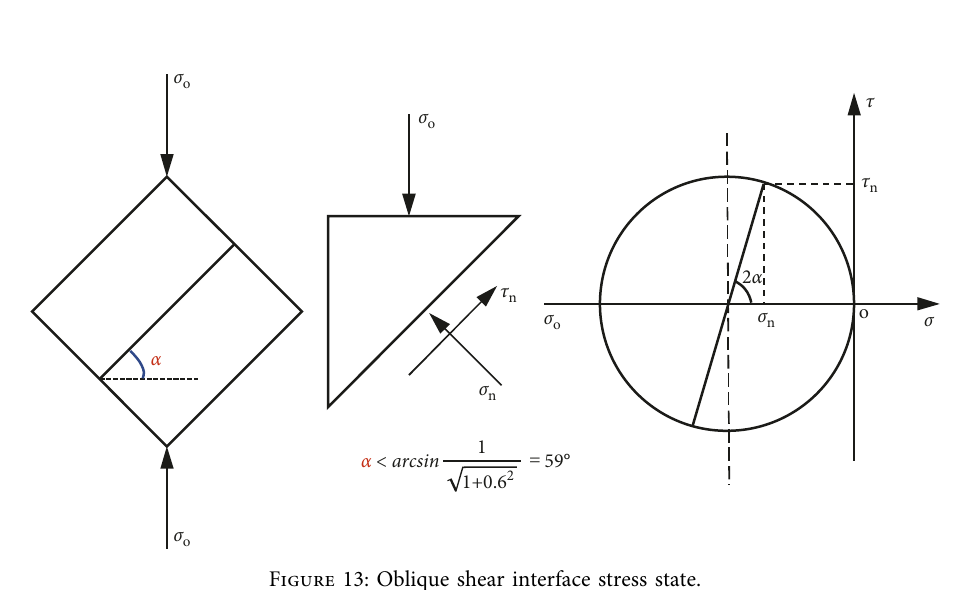
Figure 13: Oblique shear interface stress